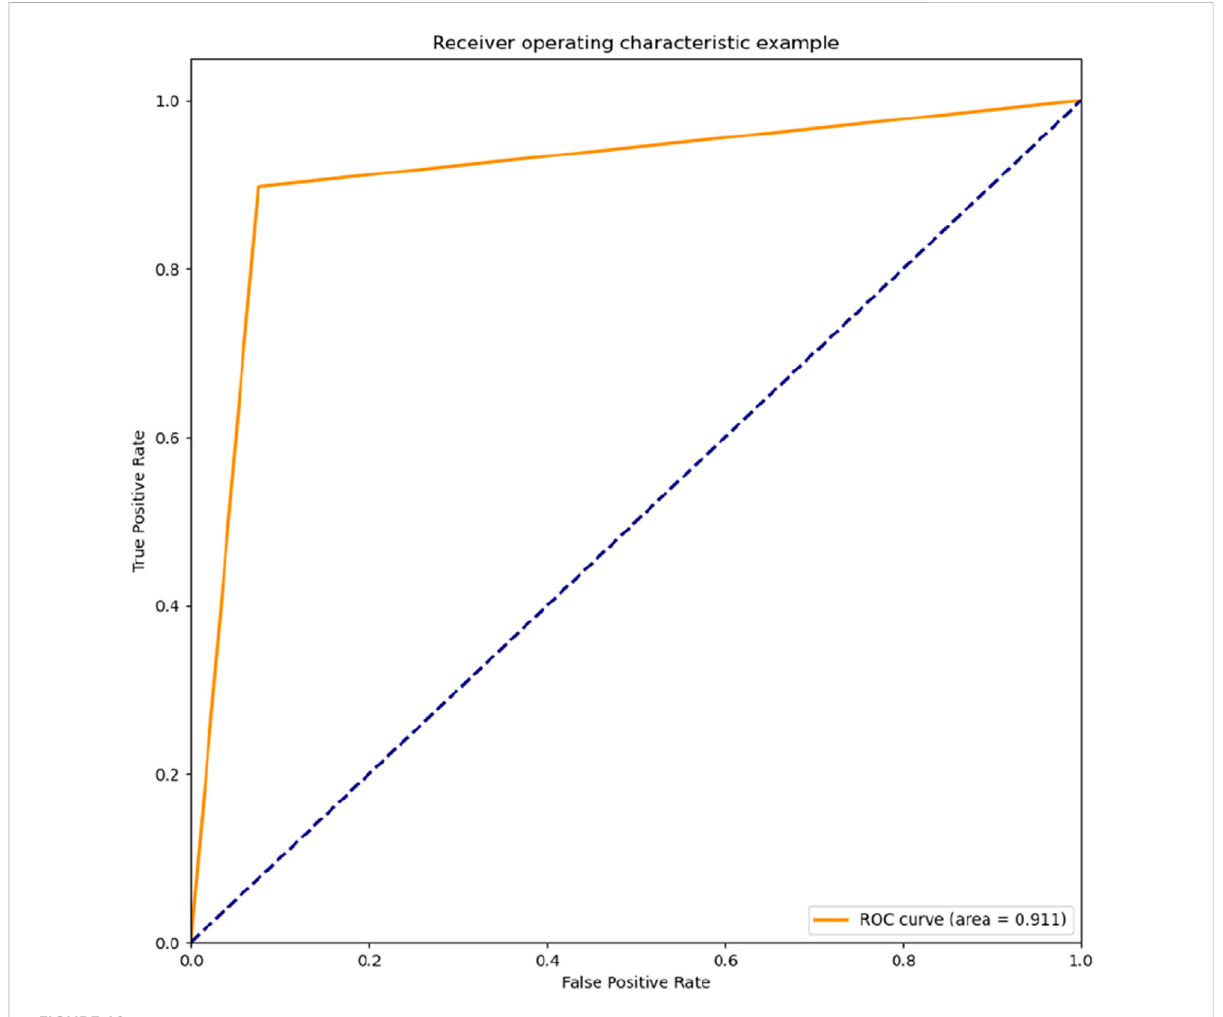
FIGURE 10 Classi fi cation model roc curve with MN as the target